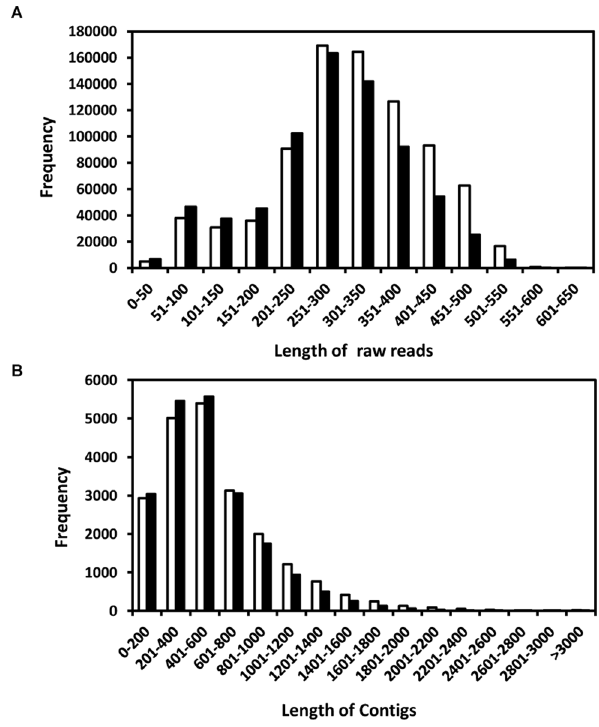
Figure 1. Size distribution of 454 high-quality reads (A) and assembled contigs (B). Black and white bars represents reads and contigs from leaf (101L) and root (101R) transcriptome data respec- tively.